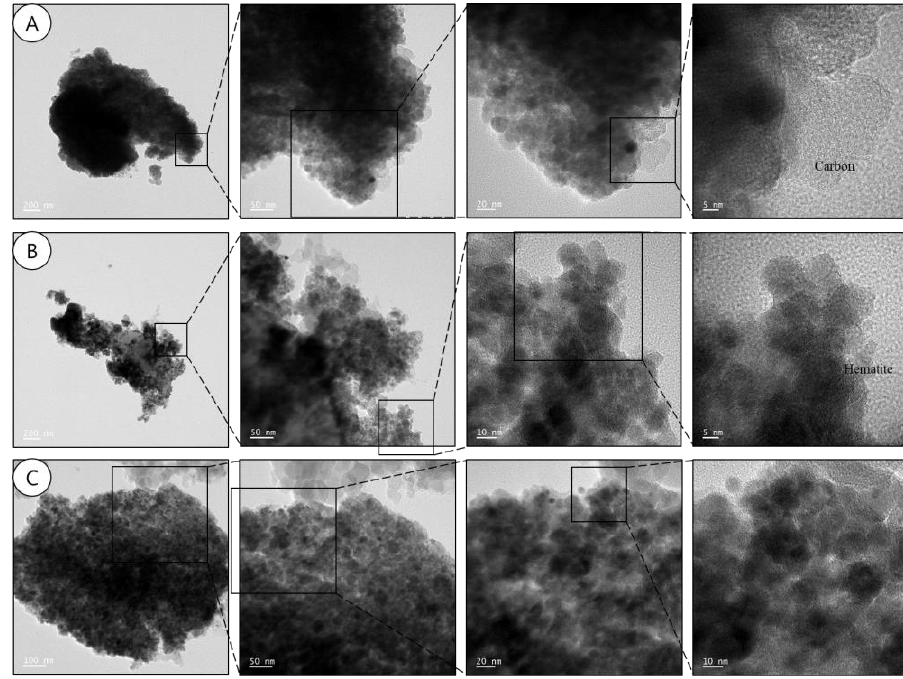
Figure 13. Morphology of PM in subway tunnels according to size at the S station. Table 5. Chemical compositions * of three samples of PM in Figure 13 (unit, %). Element